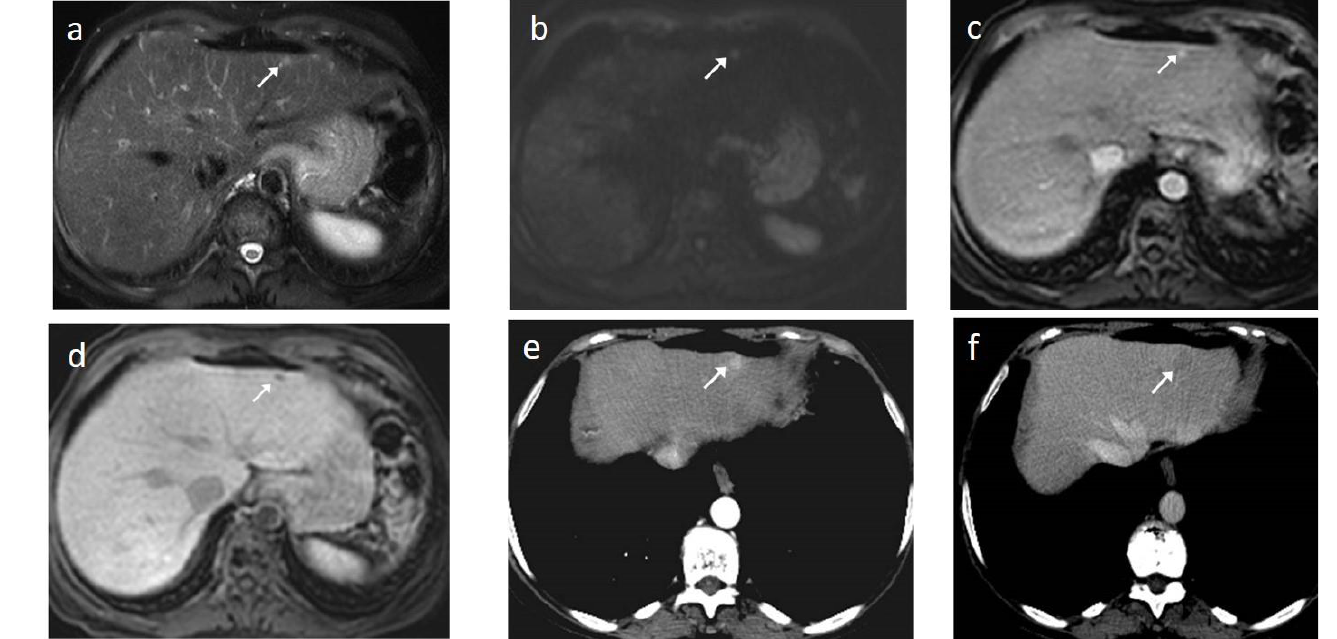
Figure 11. This 48-year-old woman with a history of β -thalassemia major and cirrhosis was followed-up after successful locoregional treatment of two small HCCs. In liver segment II, a 5-mm high T2 signal focus is seen in an anterior subcapsular location ( a ) with associated restricted diffusion (arrow) ( b ). The lesion shows arterial enhancement ( c ) and no uptake of the hepatospecific contrast on the hepatobiliary phase ( d ). Although findings are highly suspicious, the lesion cannot be definitely characterized as HCC, due to its small size. On the subsequent follow up CT, interval growth and typical wash-in/wash-out are now present ( e , f ).